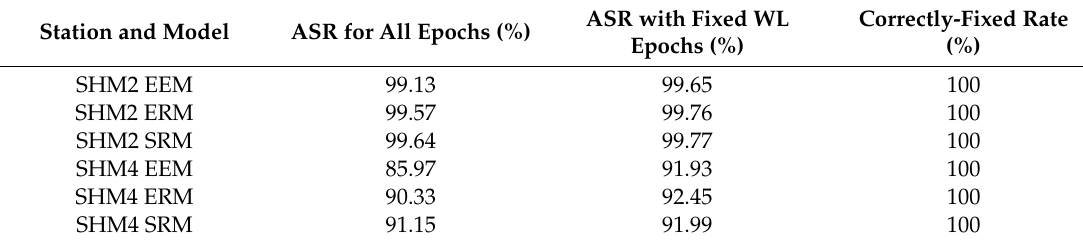
Table 2. ASR of Narrow-lane ambiguity resolution.